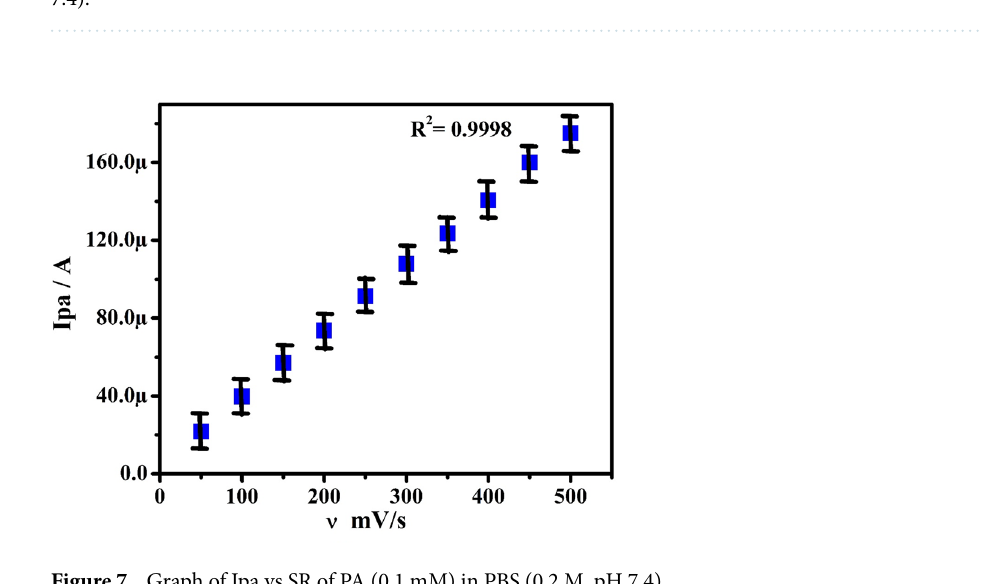
Figure 6. CVs obtained for PA (0.1 mM) at PoOCD/MCPE with various SR (50–500) mVs −1 in PBS (0.2 M, pH 7.4).